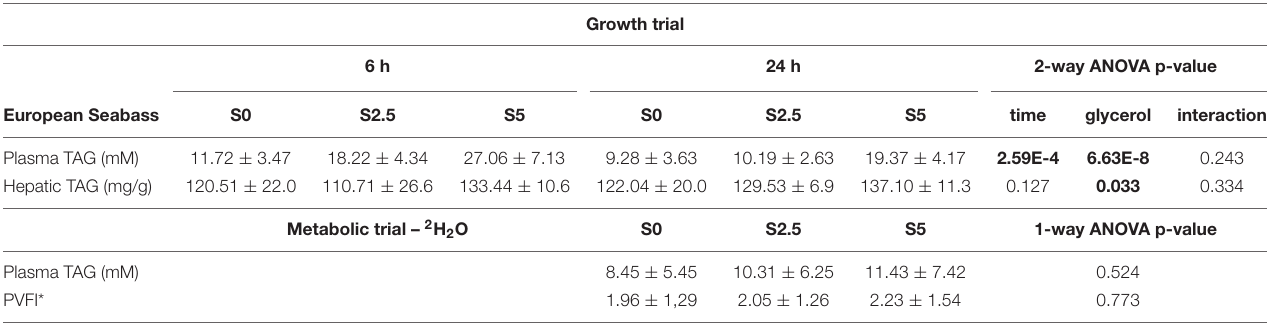
*Perivisceral Fat Index as PVFI = (perivisceral fat weight/body weight) *100. Values are mean ± SD. Significant differences in the growth trial (n = 7) were evaluated by two-way ANOVA (p < 0.05, values in bold). Significant differences between dietary treatments in the metabolic trial (n = 12) are indicated by different letters (one-way ANOVA, p < 0.05; followed by Tukey’s test). turned over with fractional synthetic rates similar to TW 2